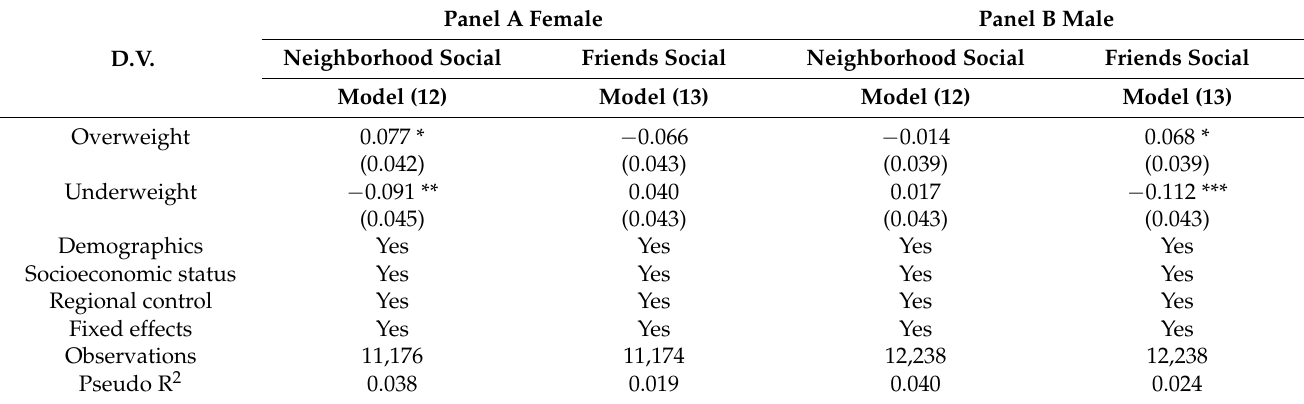
Table 8. Neighborhood social frequency and friend social frequency were used as proxy variables for socialization (1–7 frequency was increasing). Table 8. Ordered logit results of body shape impact on socialization.